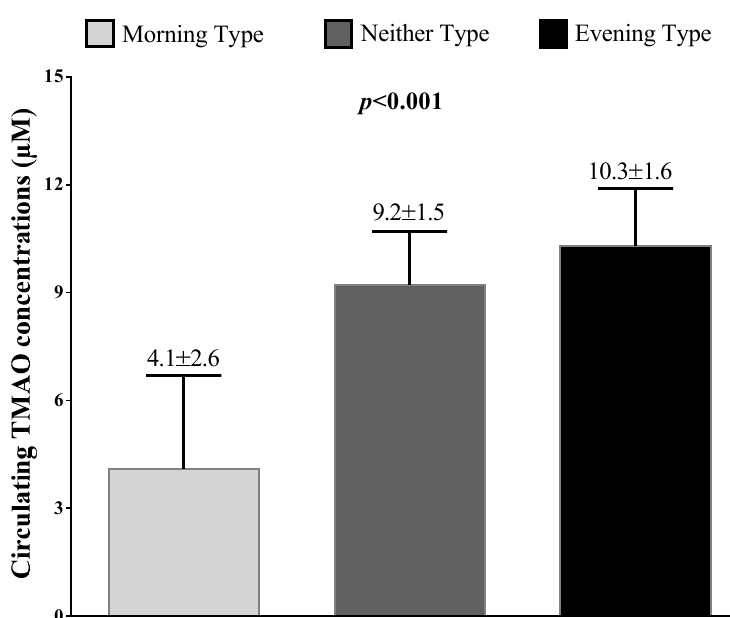
Figure 1. Circulating TMAO concentrations across chronotype categories. According to the three chronotype categories, circulating TMAO concentrations increased significantly, with the lowest values in the subjects with the morning chronotype category. Differences in the three groups were analyzed by ANOVA test, with the Bonferroni test as post hoc test. A p value in bold type denotes a significant difference ( p < 0.05). TMAO, trimethylamine N ‐ oxide.